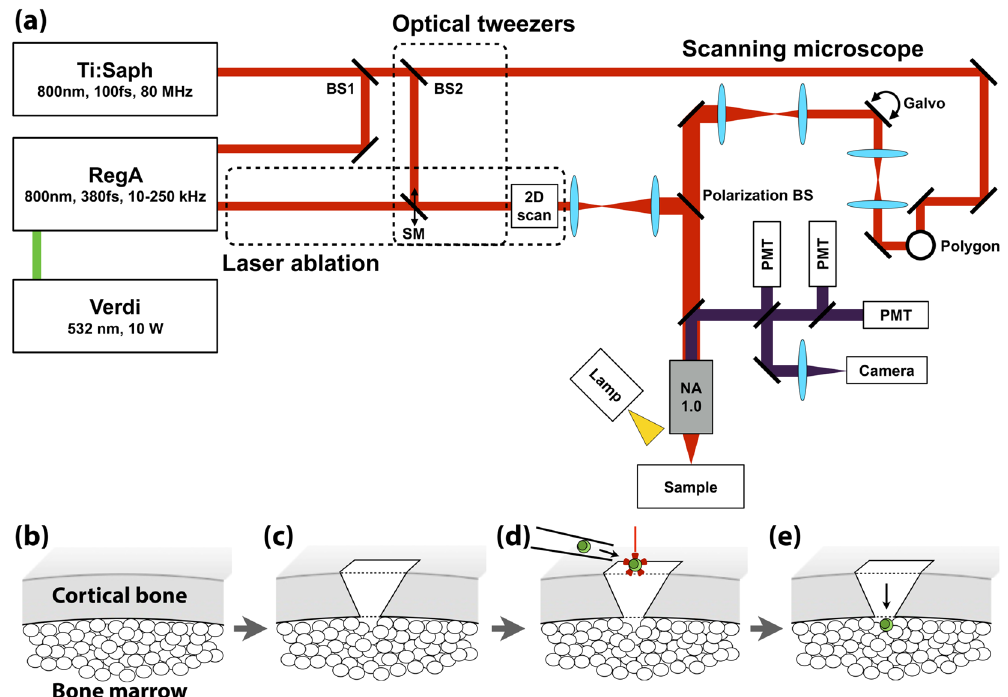
Figure 1. The optical platform for image-guided single cell transplantation. ( a ) Schematic of the optical system that integrates a video-rate laser scanning multiphoton microscope with a laser ablation beam for microsurgery and an optical tweezer for single cell trapping. ( b ) Second harmonic imaging is used to identify a location for transplantation. ( c ) The ablation laser beam is used to cut a delivery channel through the cortical bone, leaving only a hole slightly larger than the size of a cell connecting to the bone marrow cavity. ( d ) A single cell is released from a glass micropipette into the optical tweezer above the channel and ( e ) then directed by the optical trap through the